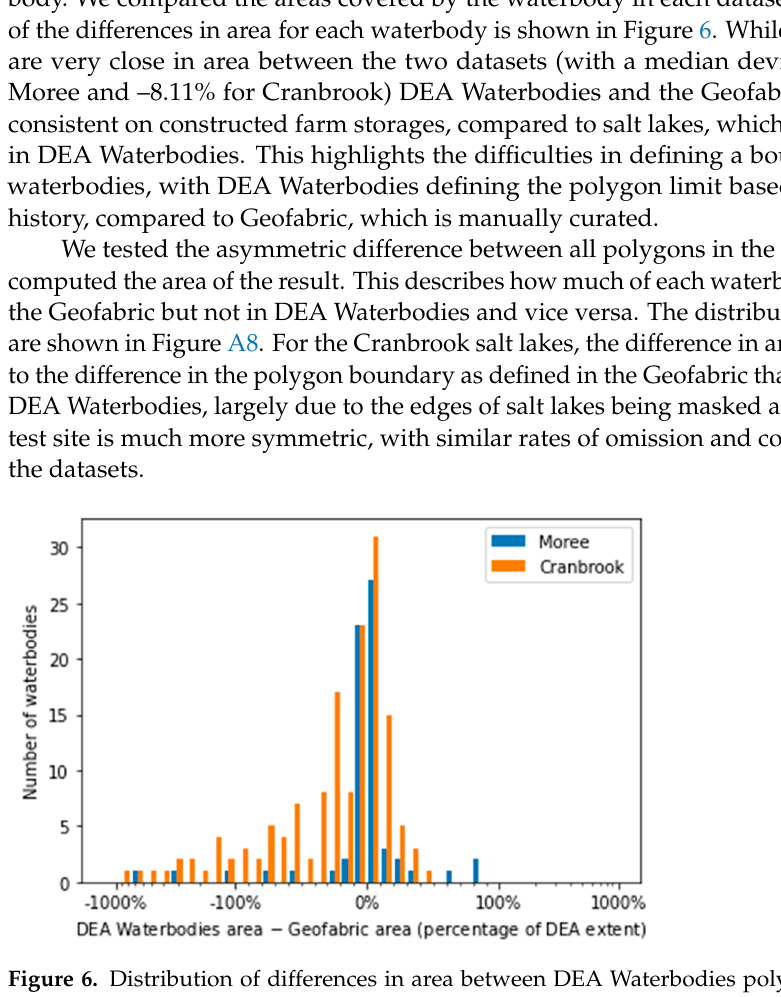
Figure 6. Distribution of differences in area between DEA Waterbodies polygons and Geofabric polygons for the Moree and Cranbrook test areas. polygons for the Moree and Cranbrook test